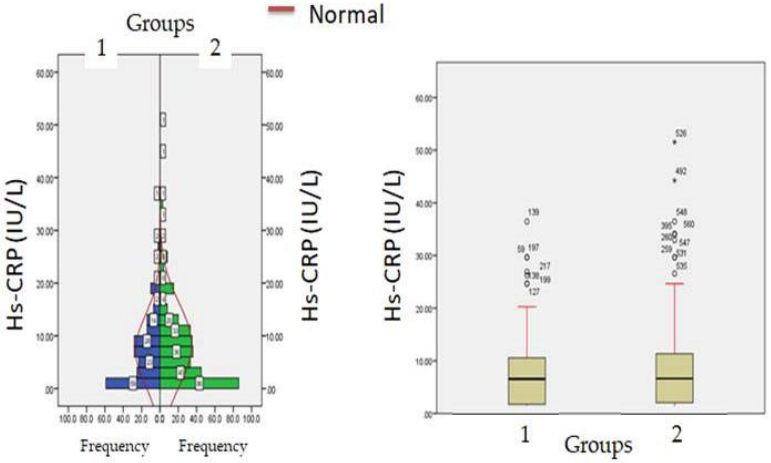
Figure 4. Hs-CRP levels at admission (hospitalization) in patients with normocreatinemia (Group-I) and hypercreatinemia (Group-2).